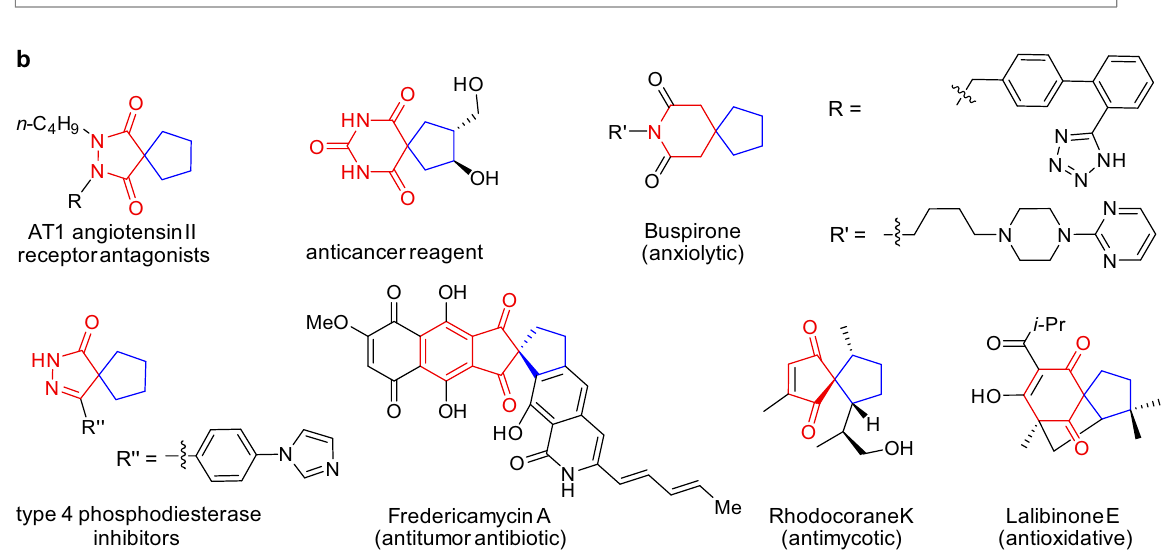
Fig. 1 Transition-metal hydride-based cycloaddition strategy for the direct catalytic asymmetric spirocycle synthesis. a Pd/WingPhos-catalyzed enantioselective cycloaddition reactions of 1,3-enynes as dielectrophilic C4 synthons. b Selected bioactive spirocyclic molecules relevant to this